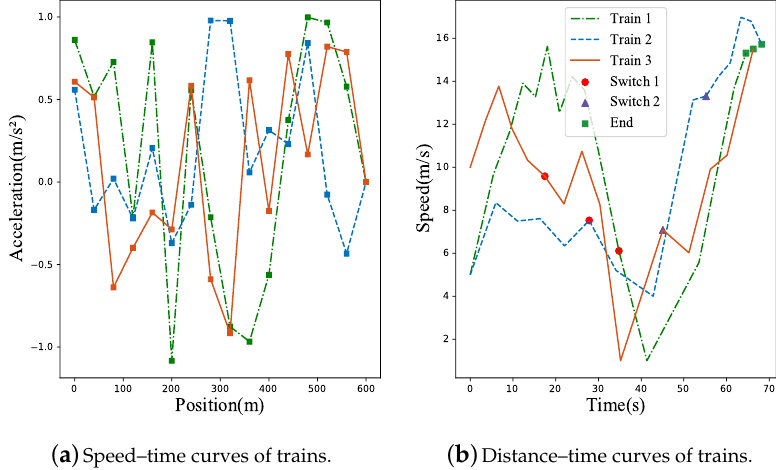
( a ) Speed–time curves of trains. ( b ) Distance–time curves of trains. Figure 8. Improved PSO strategies and operation curves in scenario